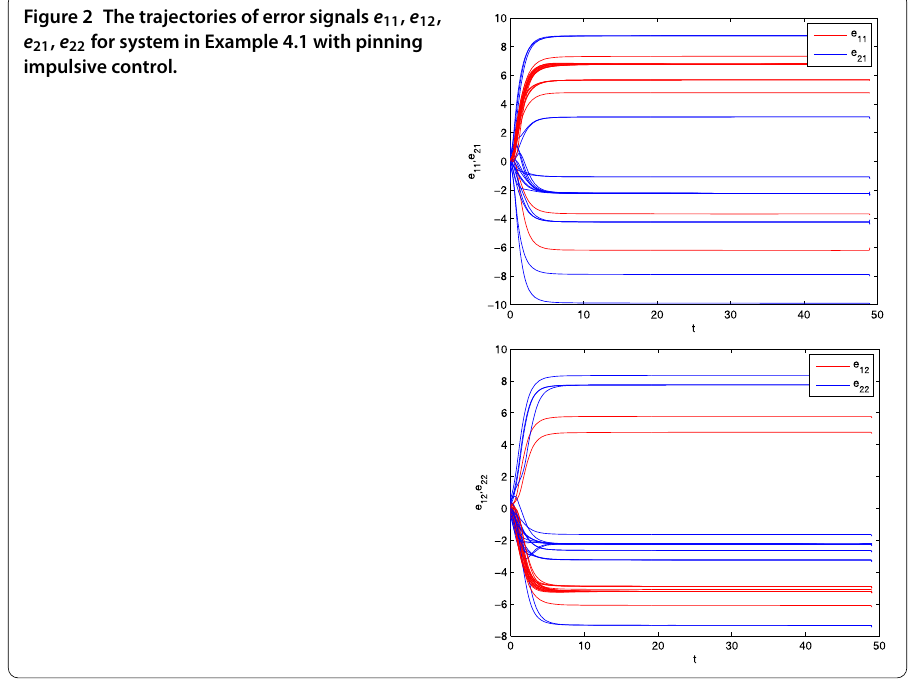
Figure 2 The trajectories of error signals e 11 , e 12 , e 21 , e 22 for system in Example 4.1 with pinning impulsive